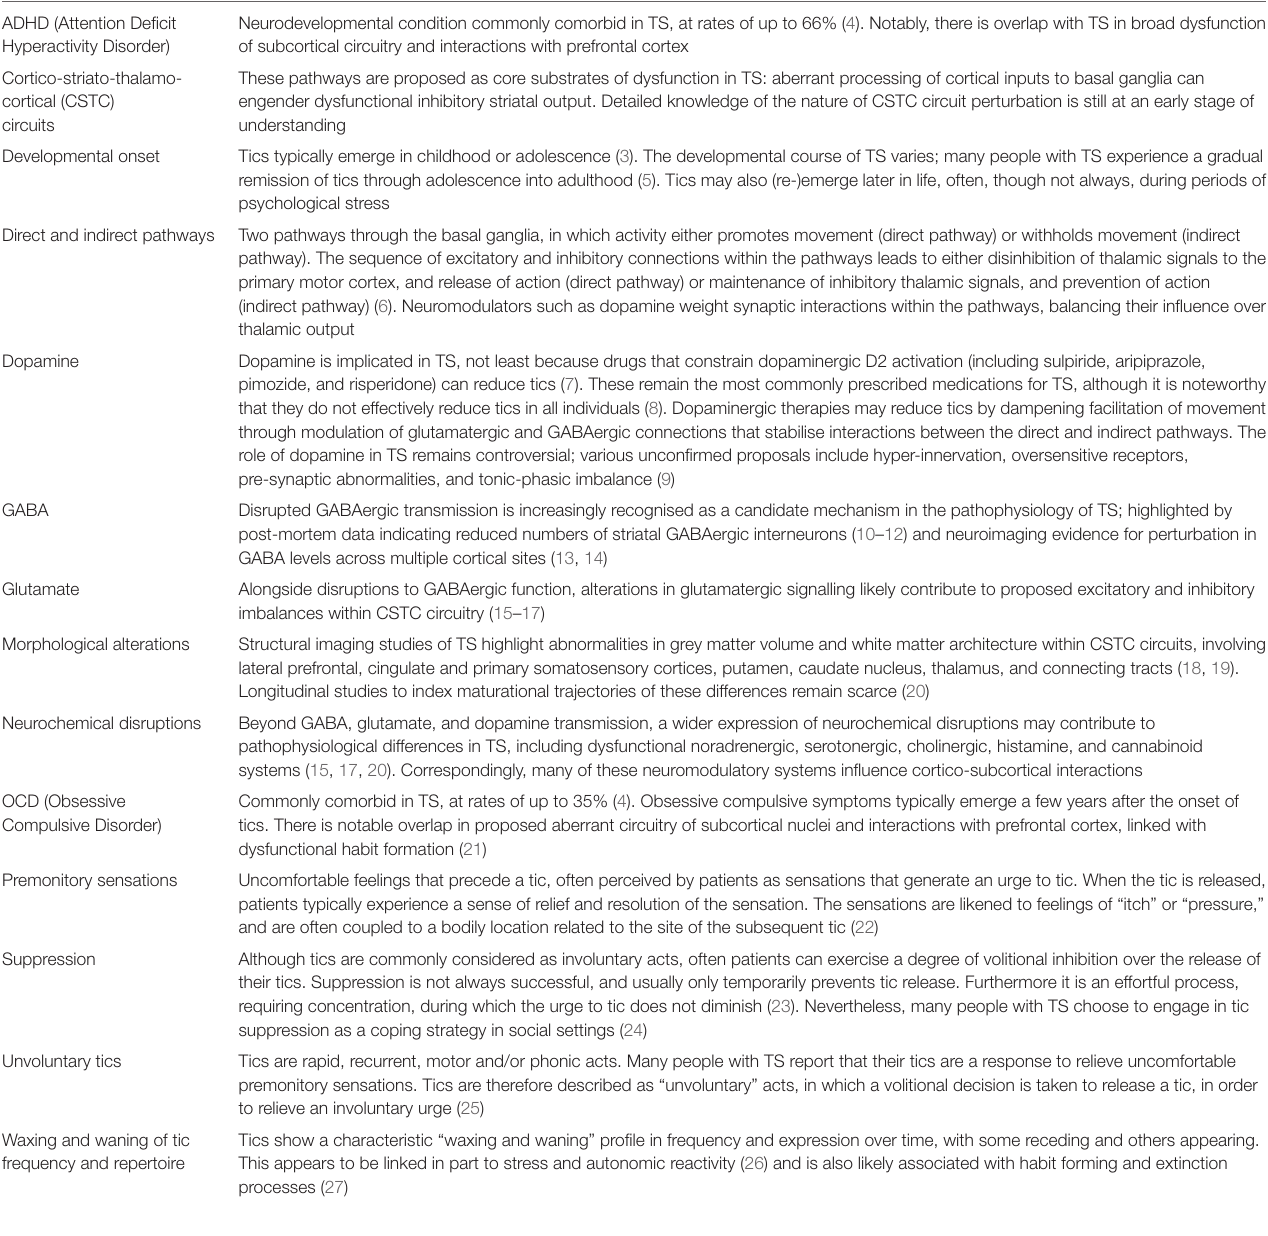
TABLE 1 | Features of Tourette